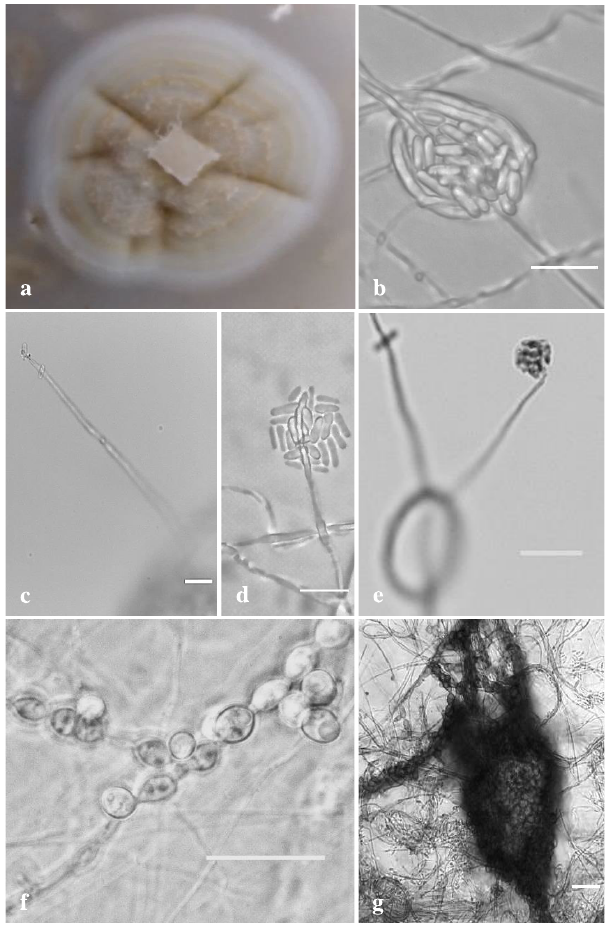
Figure 5. Circumfusicillium cavernae details of the: ( a ) Colony characteristics on OA after 21 days; ( b ) Conidia tightly packed by surrounding hyphal segments; ( c – e ) Typical conidiophores, conidial heads and conidia; ( f ) Typical chlamydospore chains; and ( g ) Chains of chlamydospores interweav- ing in long rope-like microsclerotia with textura globose . Scale bars ( b – e ) 10 µm; ( f , g ) 20 µm.